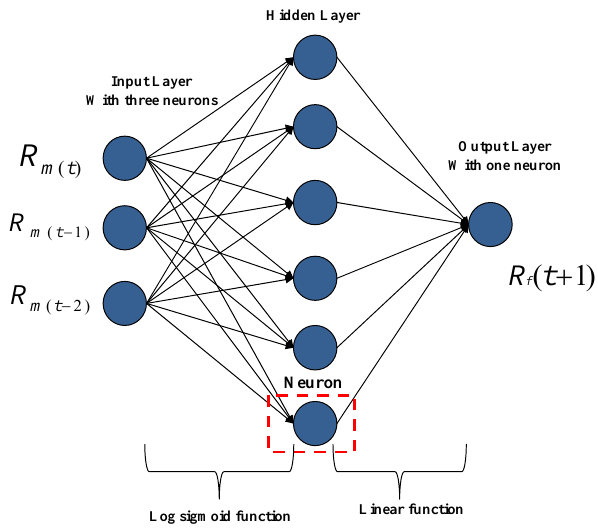
Fig. 9. Neural network model architecture utilized for rainfall fore- Figure 9 Neural network model architecture utilized for rainfall forecasting